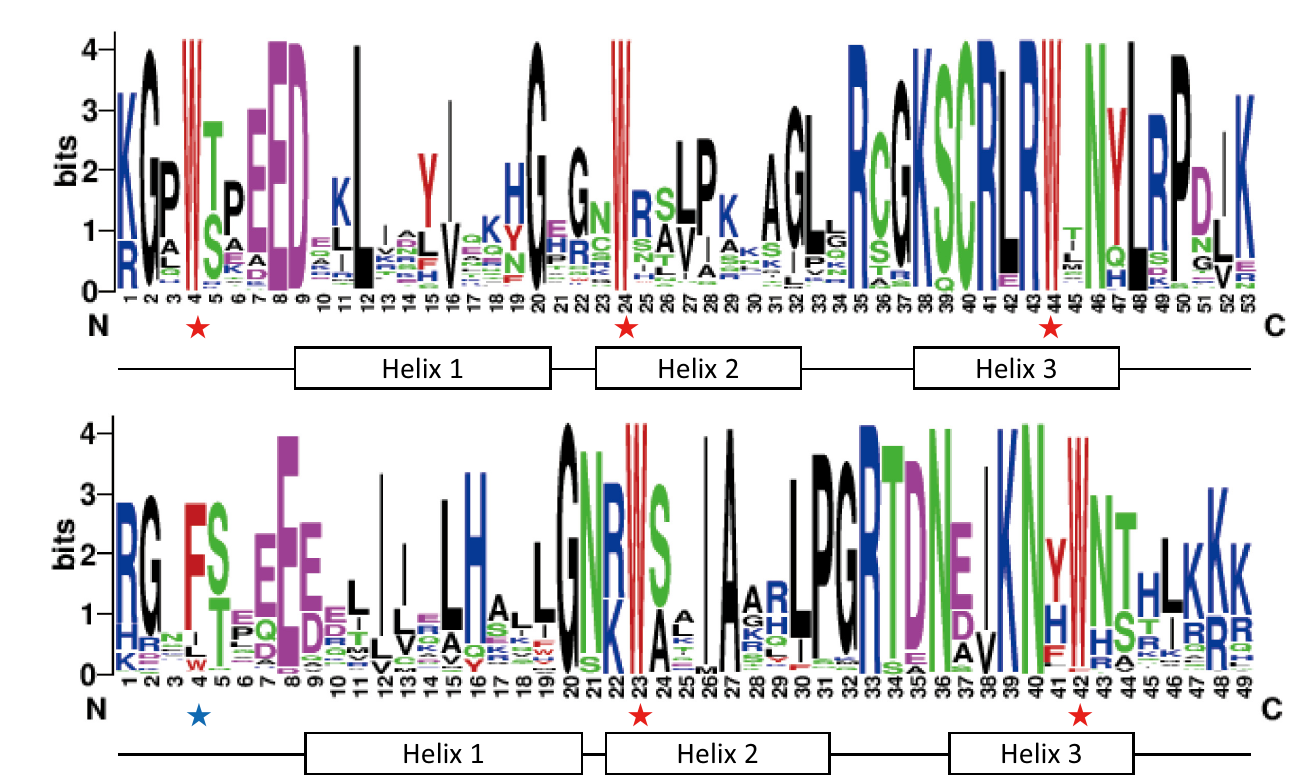
Fig 3. Sequence logos of the R2 and R3 domains of the Japanese morning glory R2R3-MYBs. Sequence logos were generated using WebLogo (http://weblogo. berkeley.edu/logo.cgi). Alignment analysis of R2 and R3 domains was performed with ClustalW and manually optimized. The overall height of each stack indicates the conservation of the amino acid residue at that position, and the bit score exhibits the relative frequency of the corresponding amino acid residue. The conserved tryptophan residues (W) are marked with red stars, while replaced residue in the R3 domain is marked with the blue star.